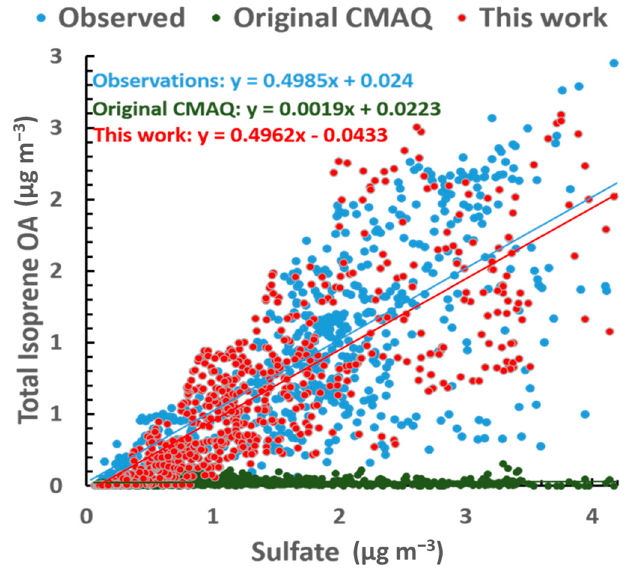
Figure 5. Isoprene organic aerosol (OA) sensitivity to H + from the Henry’s law sensitivity tests. The horizontal axis is in units of 2.7 × 10 6 M atm − 1 , which corresponds to the default H value in Table 2013. CMAQ version. The green line denotes the average observed isoprene OA.